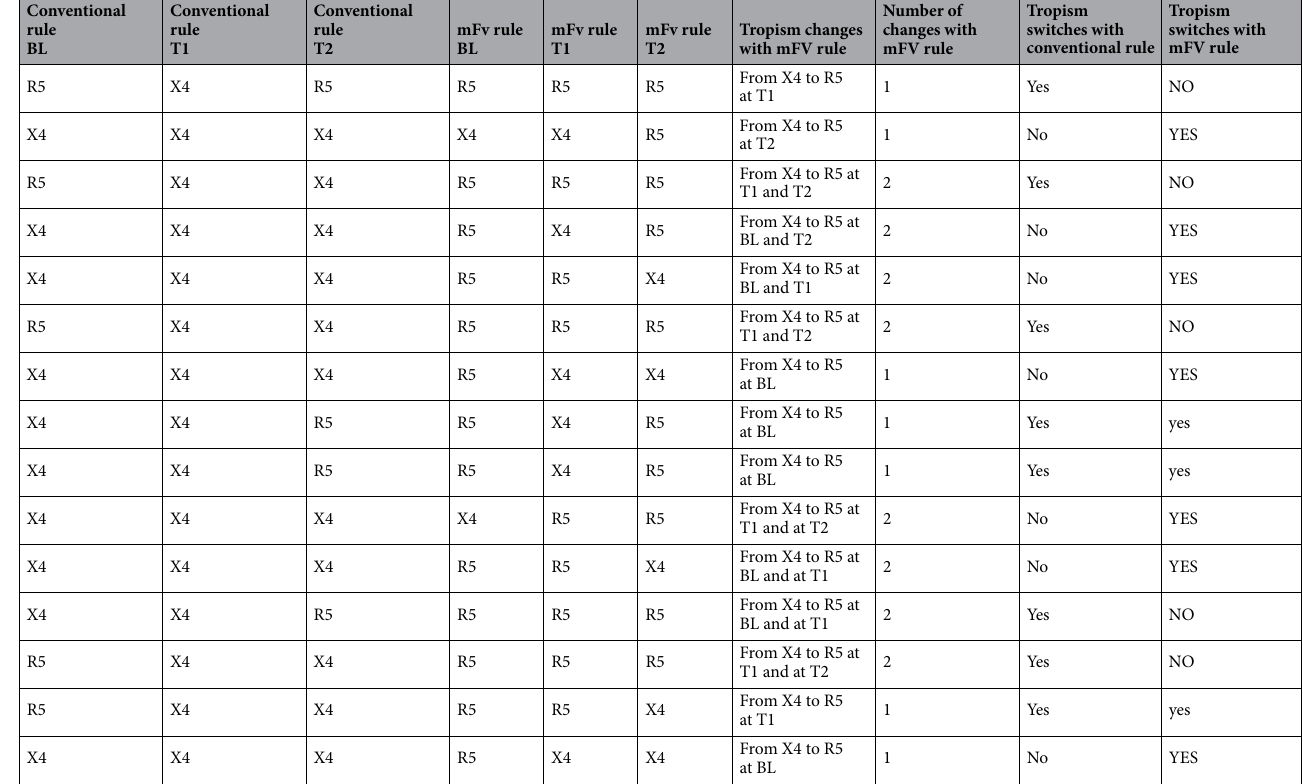
Table 5. Description of tropism results obtained with the conventional rule (FPR < 10% corresponding to X4 tropic virus) and with the mean FPR value (mFv) rule (mean FPR value of the three sequences performed for each tropism determination < 10% corresponding to X4 tropic virus). Capital letters were used to describe a different tropism evolution throughout study time when mFv rule is